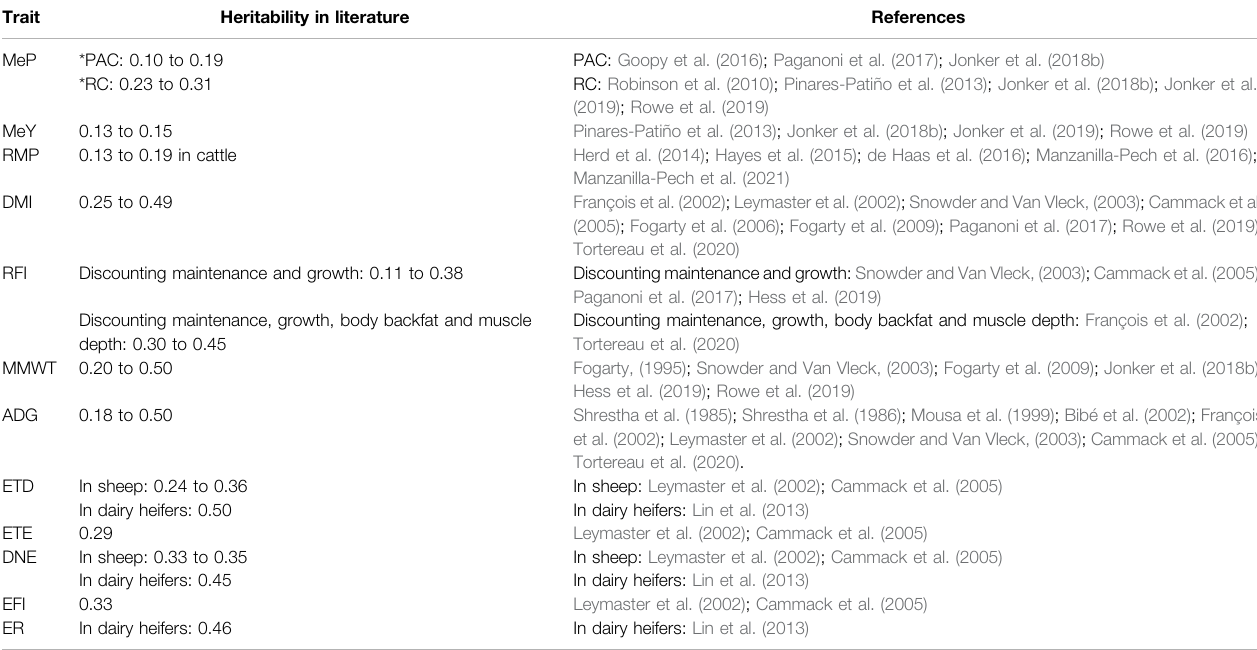
TABLE 1 | Heritability reported in literature of methane production (MeP), methane yield (MeY), residual methane production (RMP), dry matter intake (DMI), residual feed intake (RFI), metabolic mid-weight (MMWT), average daily gain (ADG), eating time per day (ETD), eating time per eating event (ETE), daily number of events (DNE), event feed intake (EFI), and eating rate (ER). * PAC: portable accumulation chamber, RC: respiration